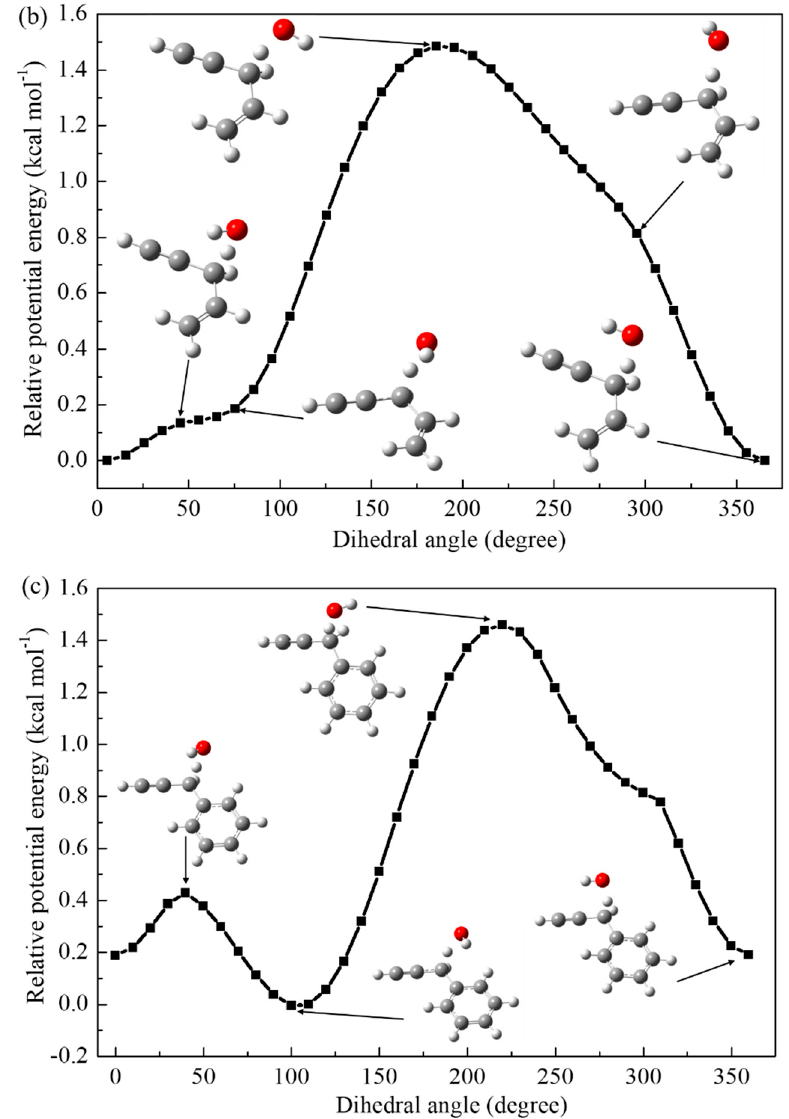
Figure 3. Relative potential energies of the internal rotation of H atom in OH radical along the reaction center for 1-butyne ( a ), 4-penten-1-yne ( b ), and 3-phenyl-1-propyne ( c ), respectively.